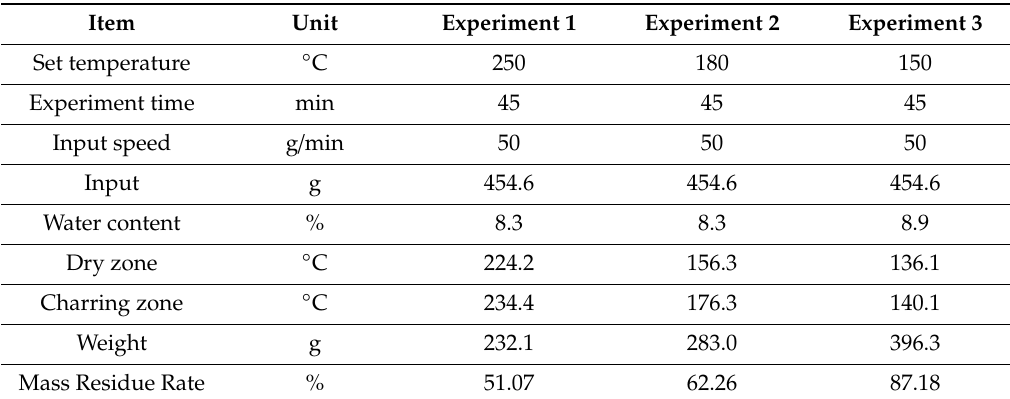
Table 2. Torrefaction experiment